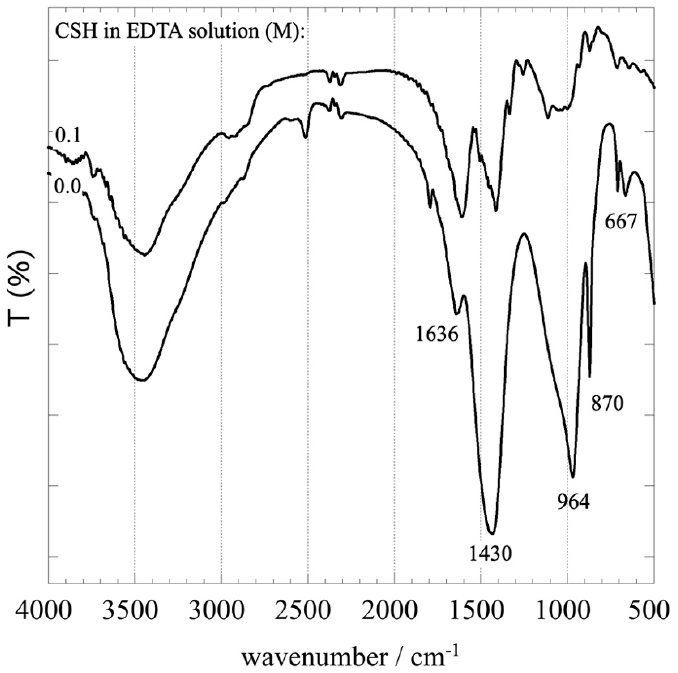
Figure 2. FTIR spectra of a C-S-H solid phase in contact with de-ionized water and 0.1 M EDTA solution.